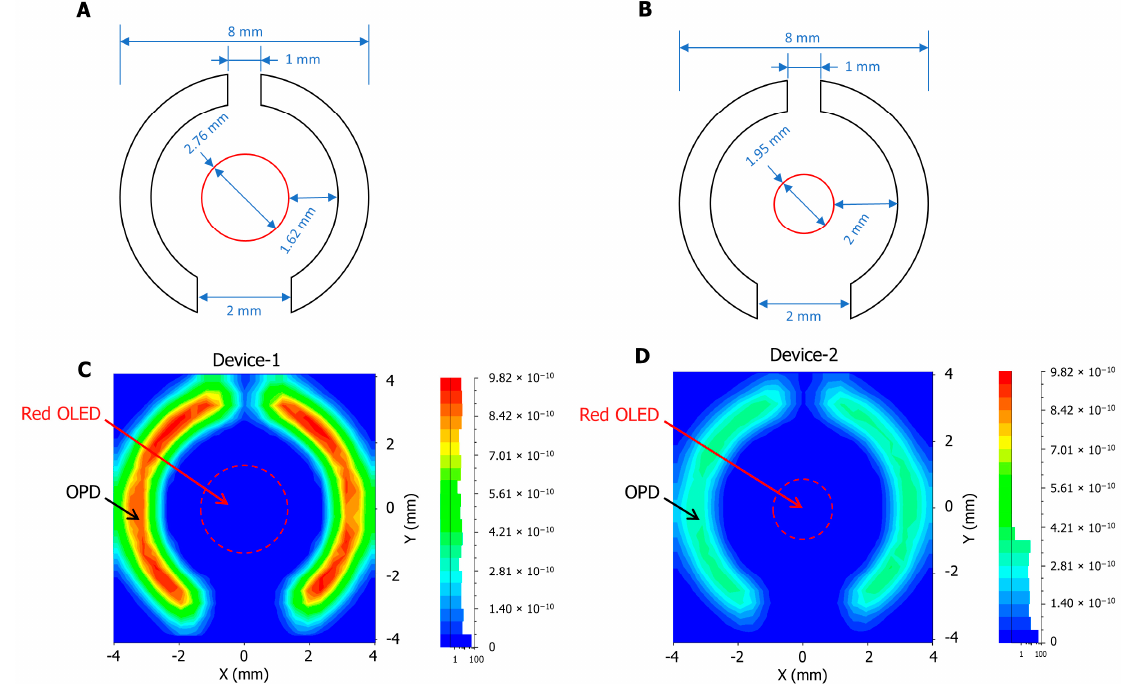
Figure 4. The dimensions of the OLED and OPD design structure in ( A ) Device-1 and ( B ) Device-2. The optical simulation results at the receiver’s surface in Watt per mm 2 for ( C ) Device-1 and ( D )